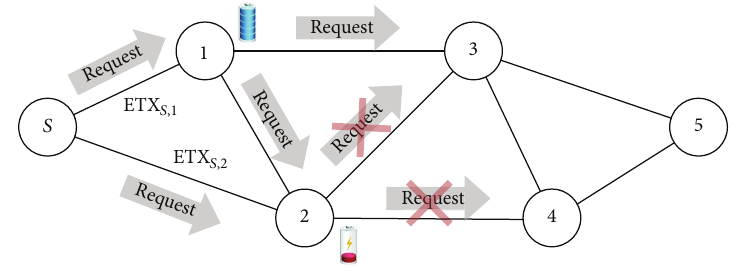
Figure 3: Example of the EEPR algorithm.